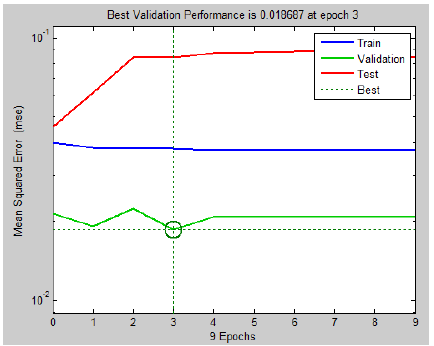
Figure 19. Result of validation for NARX neural networks created with 4 neurons in the only hidden layer. Source: By Authors.